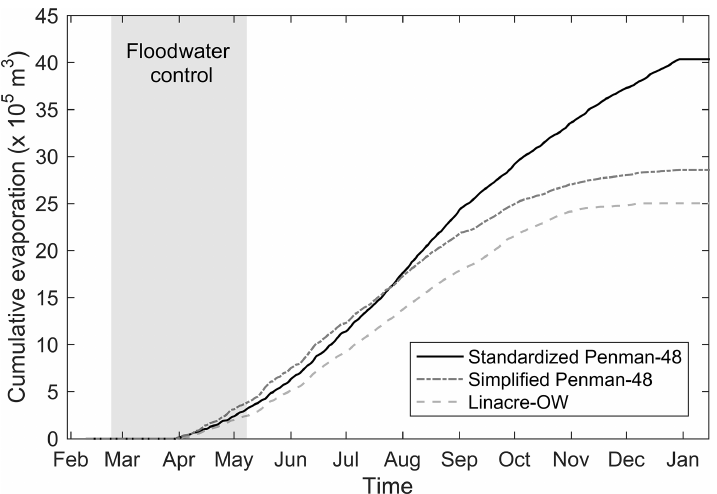
Figure C1. Cumulative evaporative fluxes from lake A via the standardized Penman-48, simplified Penman-48 (Valiantzas, 2006), and Linacre-OW (Linacre, 1977)